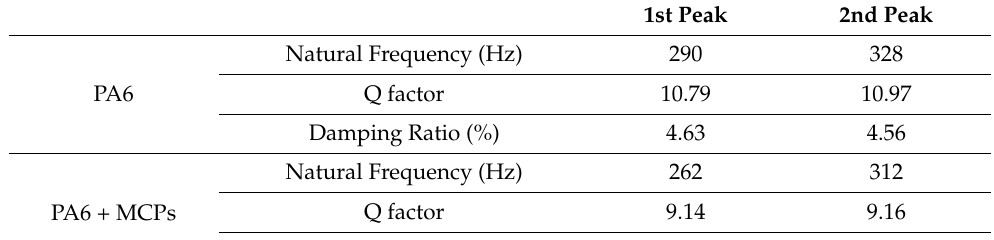
Figure 5. Effects of MCPs on vibration response of plate specimen. Table 1. Vibration characteristics from FRF curves from Figure 5.